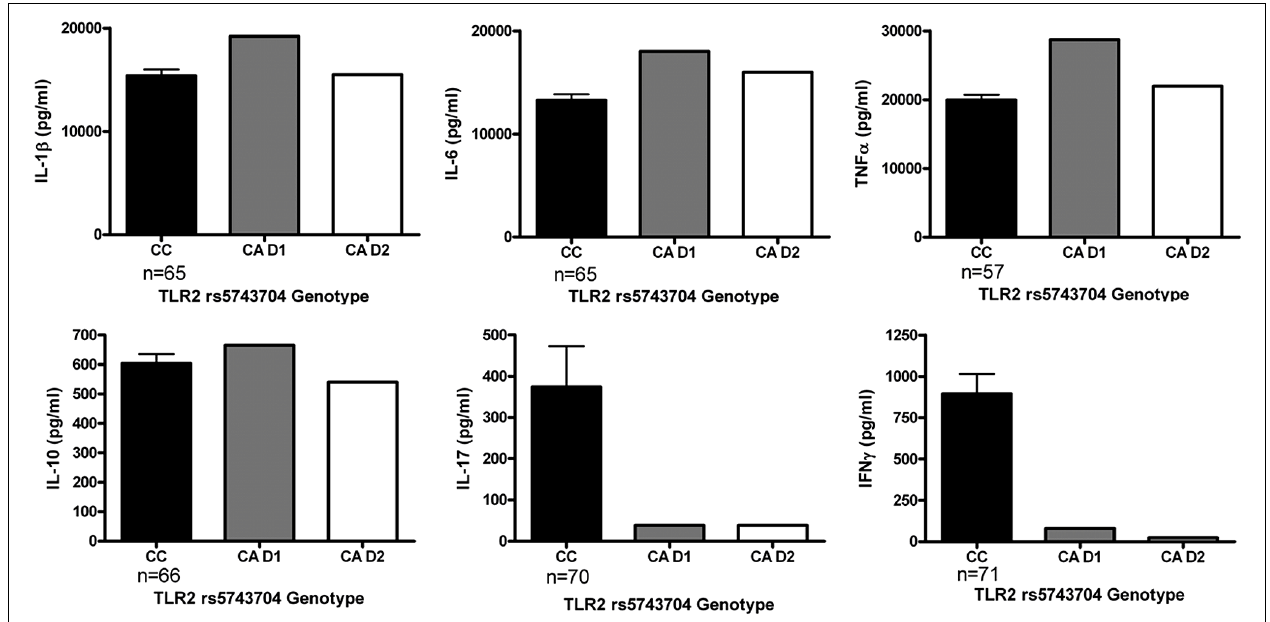
FIGURE 2 | Functional analysis on the stimulation with heat-killed Candida albicans of peripheral blood mononuclear cells (PBMCs) with different TLR2 Pro631His genotypes. Cytokine production capacity of TNF α , IL-1 β , IL-6, IL-10, IL-17, and IFN γ was